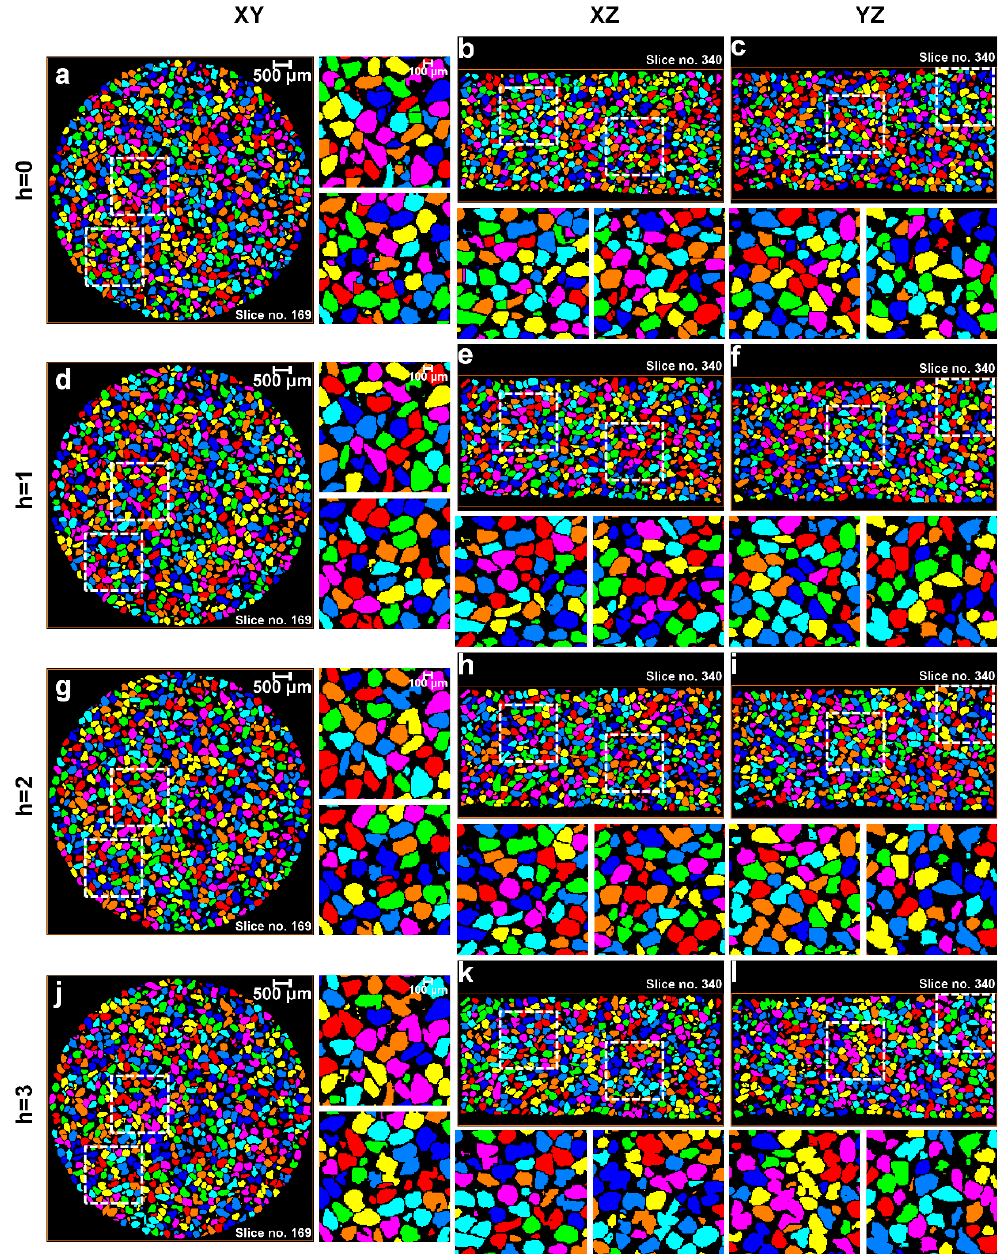
Figure 10. Separation outcomes (XY, XZ, and YZ views through the centre of the sand volumes) for the sand volume compressed under no load and separated using the watershed method with a h -value of: ( a – c ) h = 0; ( d – f ) h = 1; ( g – i ) h = 2; and ( j – l ) h = 3.